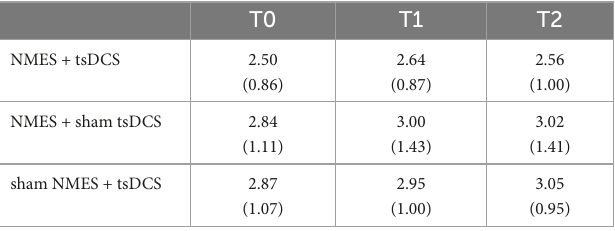
TABLE 2 Changes in M-max before and after combined stimulation using neuromuscular electrical stimulation (NMES) and transcutaneous spinal direct current stimulation (tsDCS).